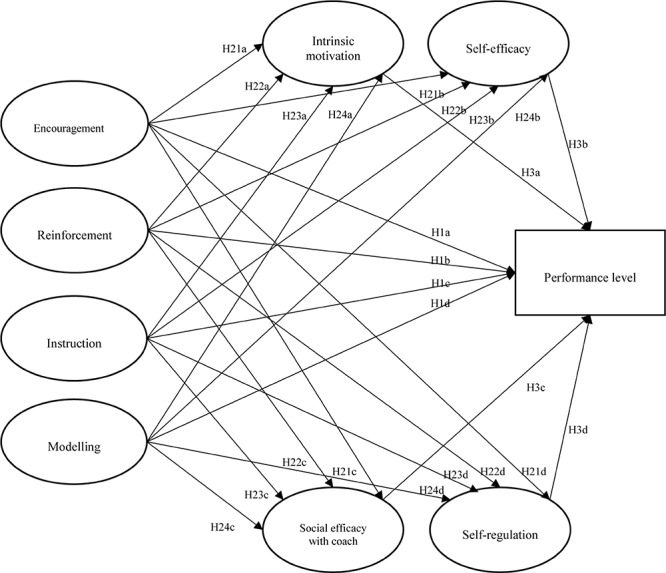
Hypothesized model.